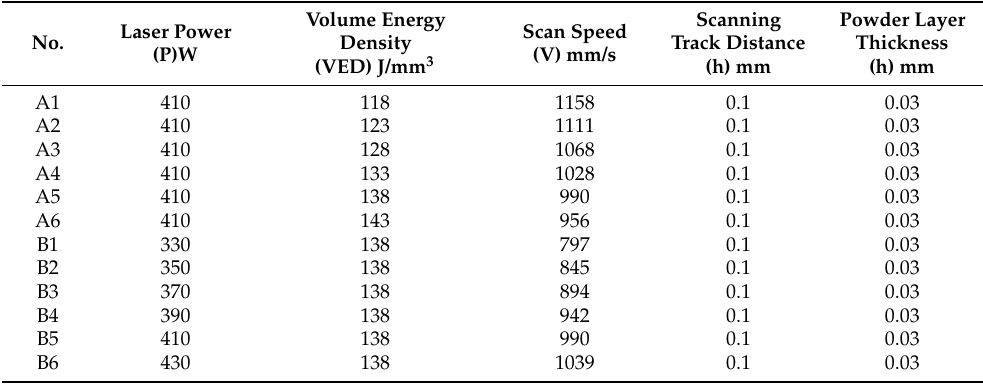
Table 2. Processing parameters of